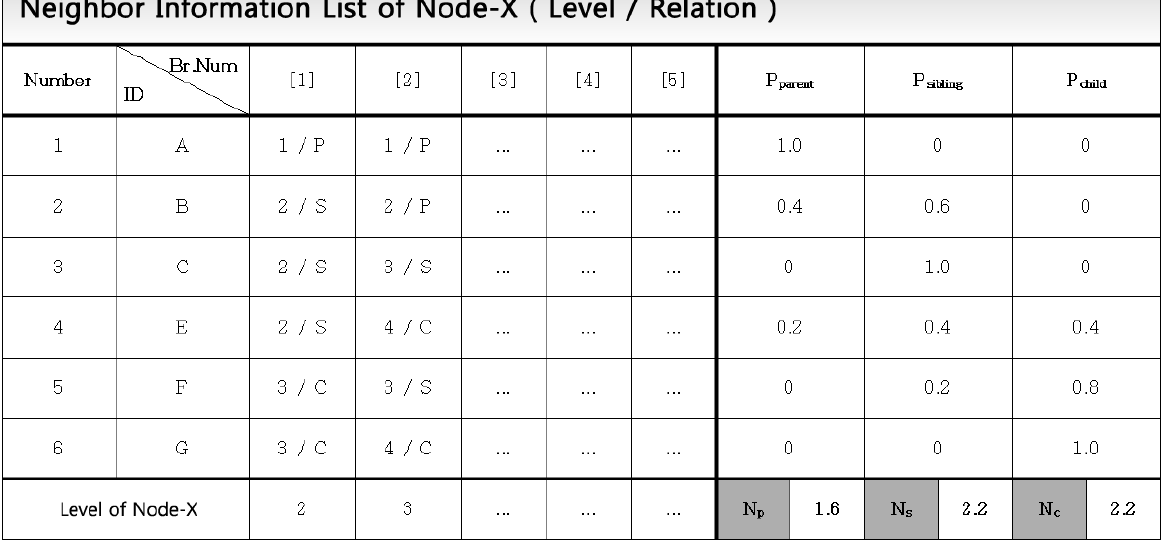
Figure 10. Example of computing the neighbor node